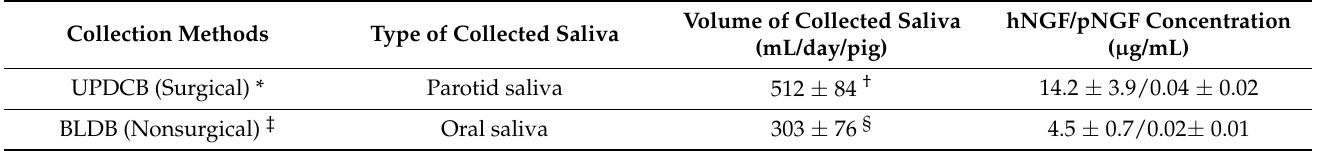
Table 2. Comparison of two saliva collection